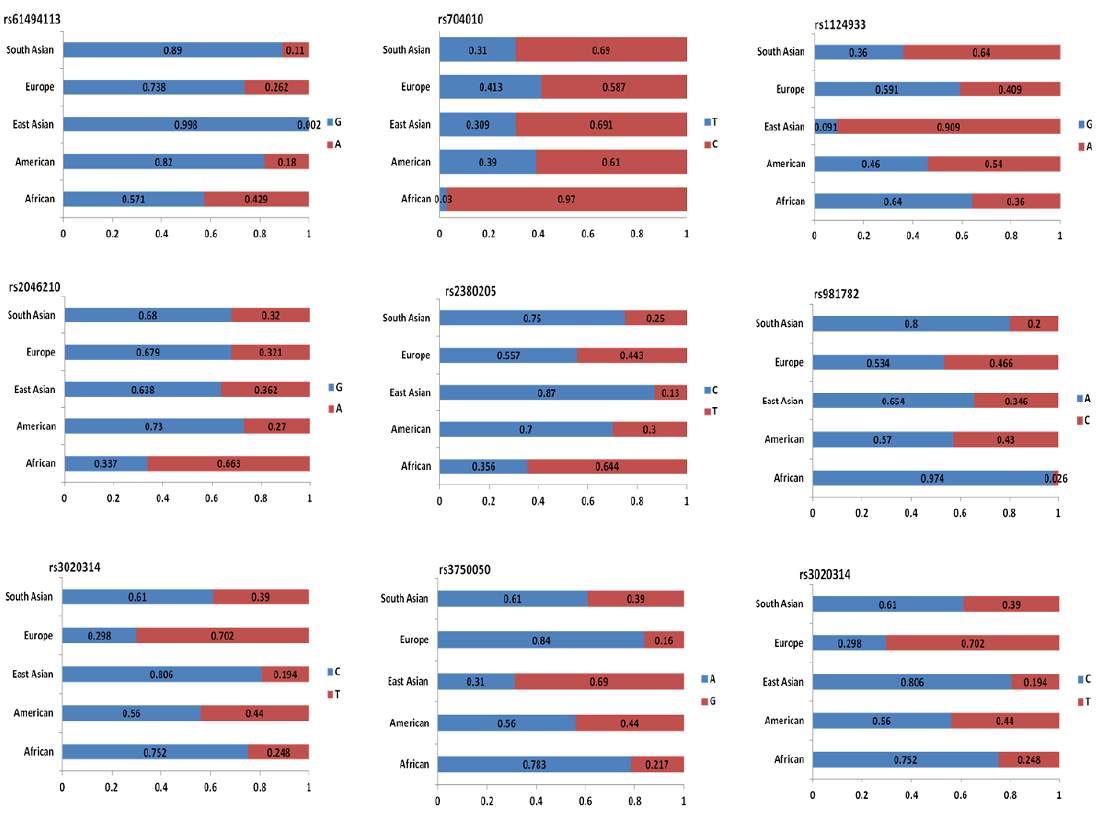
Figure 6. Divergent bar graphs illustrating significant differences among subpopulation frequencies noted in TNBC-related SNPs. Abbreviations: A, adenine, C, cytosine; G, guanine; T, thymine. It has been reported that approximately 14% of all TNBC cases correspond to mutations in high- and moderate-penetrance breast cancer genes [61,62]. The clinical utility of GWAS in determining those high-penetrance breast cancer gene mutations was initially very high back in the 1990s, when BRCA1 and BRCA2 were first cloned. Currently, it is now widely accepted that there are no other